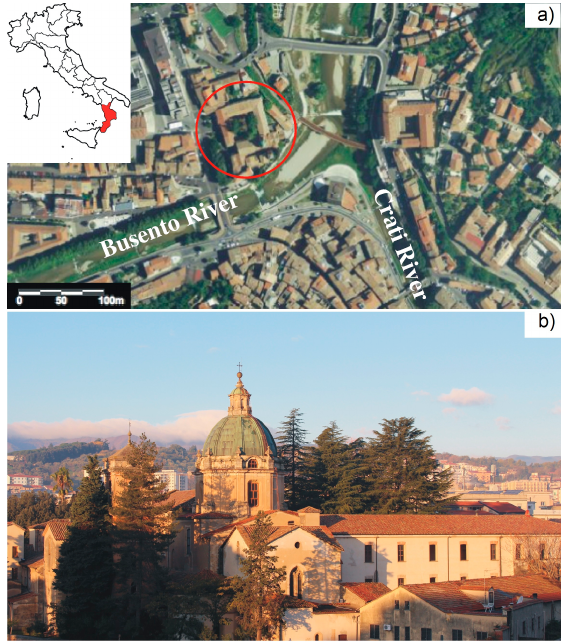
Figure 1. ( a ) Cosenza city map: red circle indicates the San Domenico church; ( b ) panoramic view of the San Domenico church.